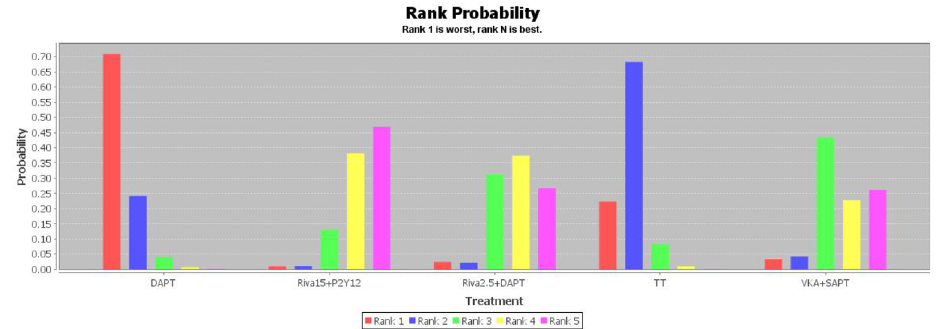
Fig 3. The distribution of MACCEs probabilities of 5 treatmentsbeing ranked at possible positions. MACCEs, main adverse cardiacand cerebrovascular events; DAPT, dual-antiplatelet therapy; Riva15 + P2Y 12 , rivaroxaban 15 mg/d plus P2Y 12 inhibitor;Riva2.5 + P2Y 12 , rivaroxaban 2.5 mg bid plus P2Y 12 inhibitor;TT, triple-antiplatelet therapy; VKA, vitamin K antagonist; SAPT, single